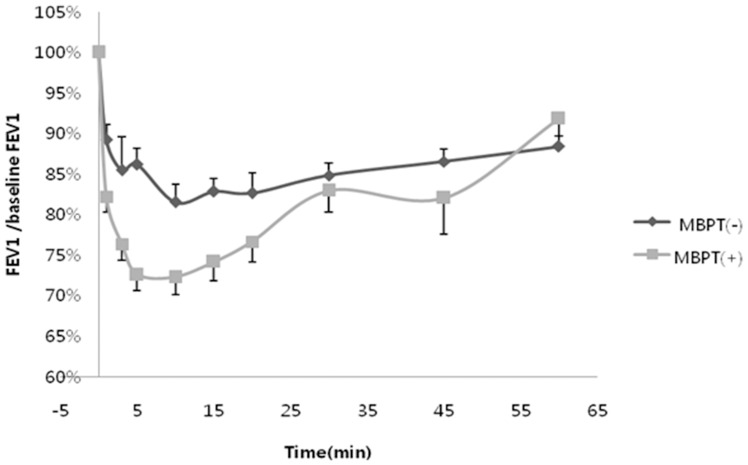
Decrement in FEV1 during exercise provocation test in patients with EIB based on methacholine reactivity.MBPT: methacholine bronchial provocation test.